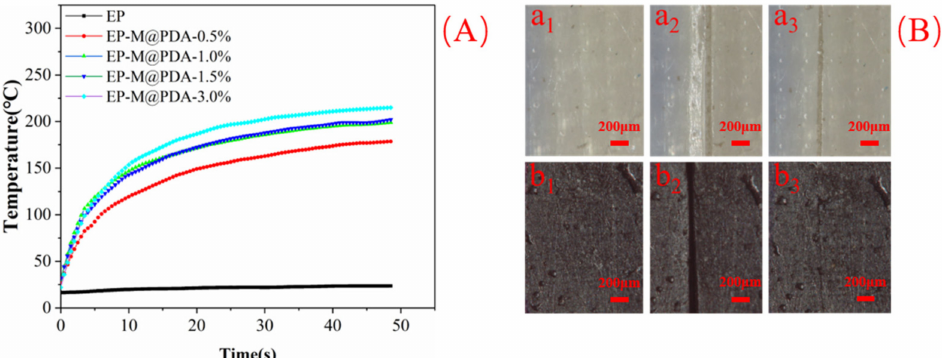
Figure 14. ( A ) Surface temperature change of epoxy composites with irradiation time. ( B ) Surface images of ( a 1 , b 1 ) images of original neat epoxy and EP-M@PDA-1.0% ( a 2 , b 2 ) images of neat epoxy and EP-M@PDA-1.0% scratched ( a 3 , b 3 ) images of neat epoxy and EP-M@PDA-1.0% after NIR irradiation for 2